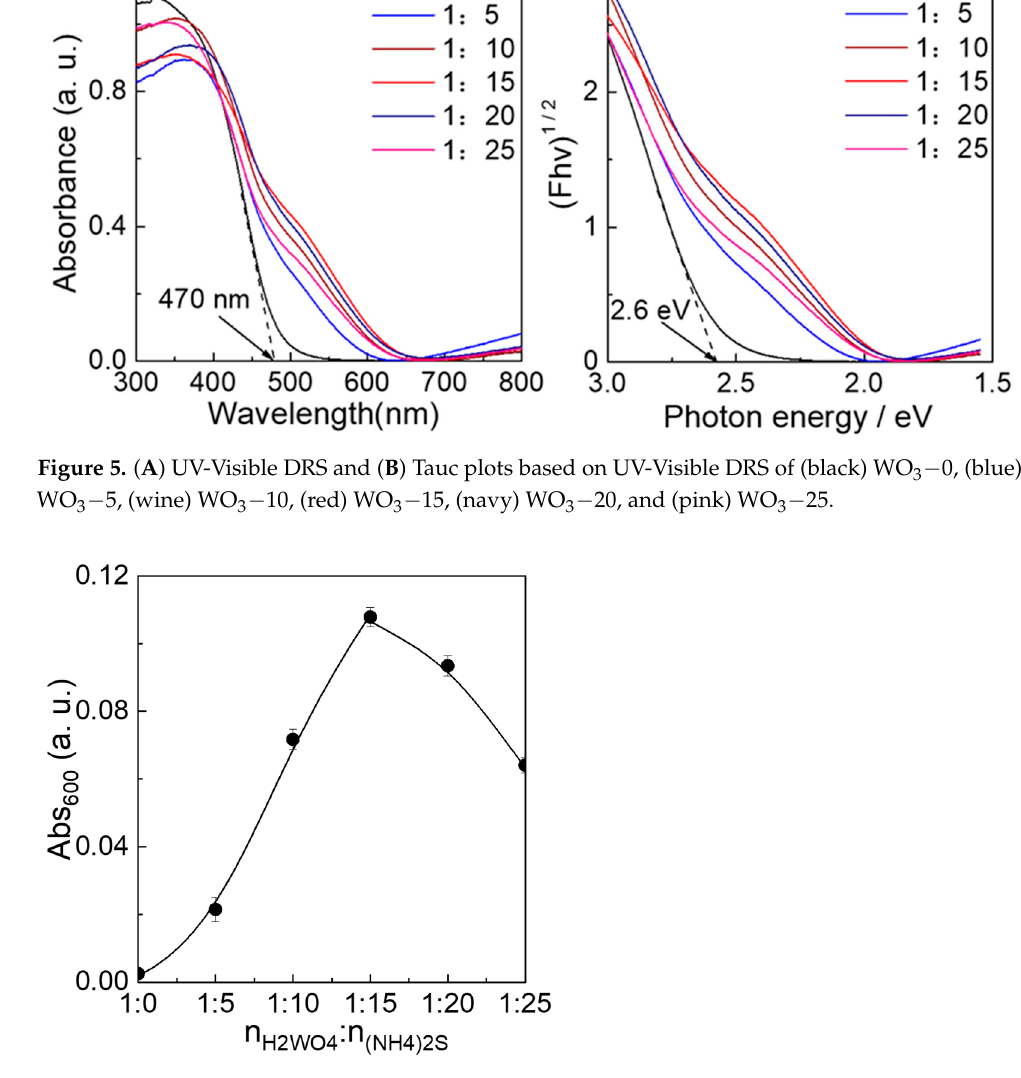
Figure 6. The absorbance values at 600 nm for the synthesized materials (WO 3 − 0, WO 3 − 5, WO 3 − 10, WO 3 − 15, WO 3 − 20, and WO 3 − 25).